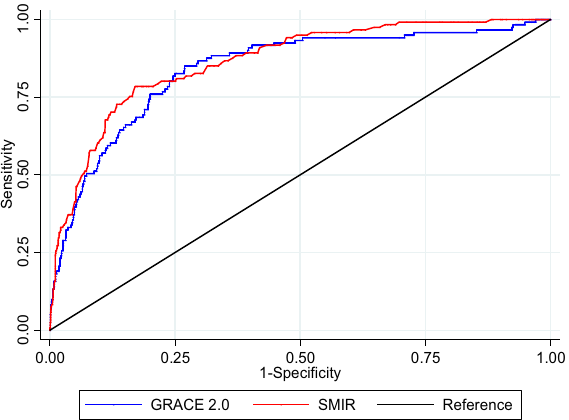
Figure 2. Receiver operator characteristics curves of the GRACE 2.0 and modified SMIR scores. The areas under the curve of the GRACE 2.0 (blue) and modified SMIR (red) scores were plotted and estimated to compare the performance of the two scores among the AMI patients in SMIR. AUC (95% CI) of GRACE 2.0 score: 0.841 (0.802–0.880). AUC (95% CI) of modified SMIR score: 0.865 (0.833–0.898). No statistically significant difference in AUC between the two scores: p = 0.075. AUC area under the curve, CI confidence interval, GRACE Global Registry of Acute Coronary Events, SMIR Singapore Myocardial Infarction